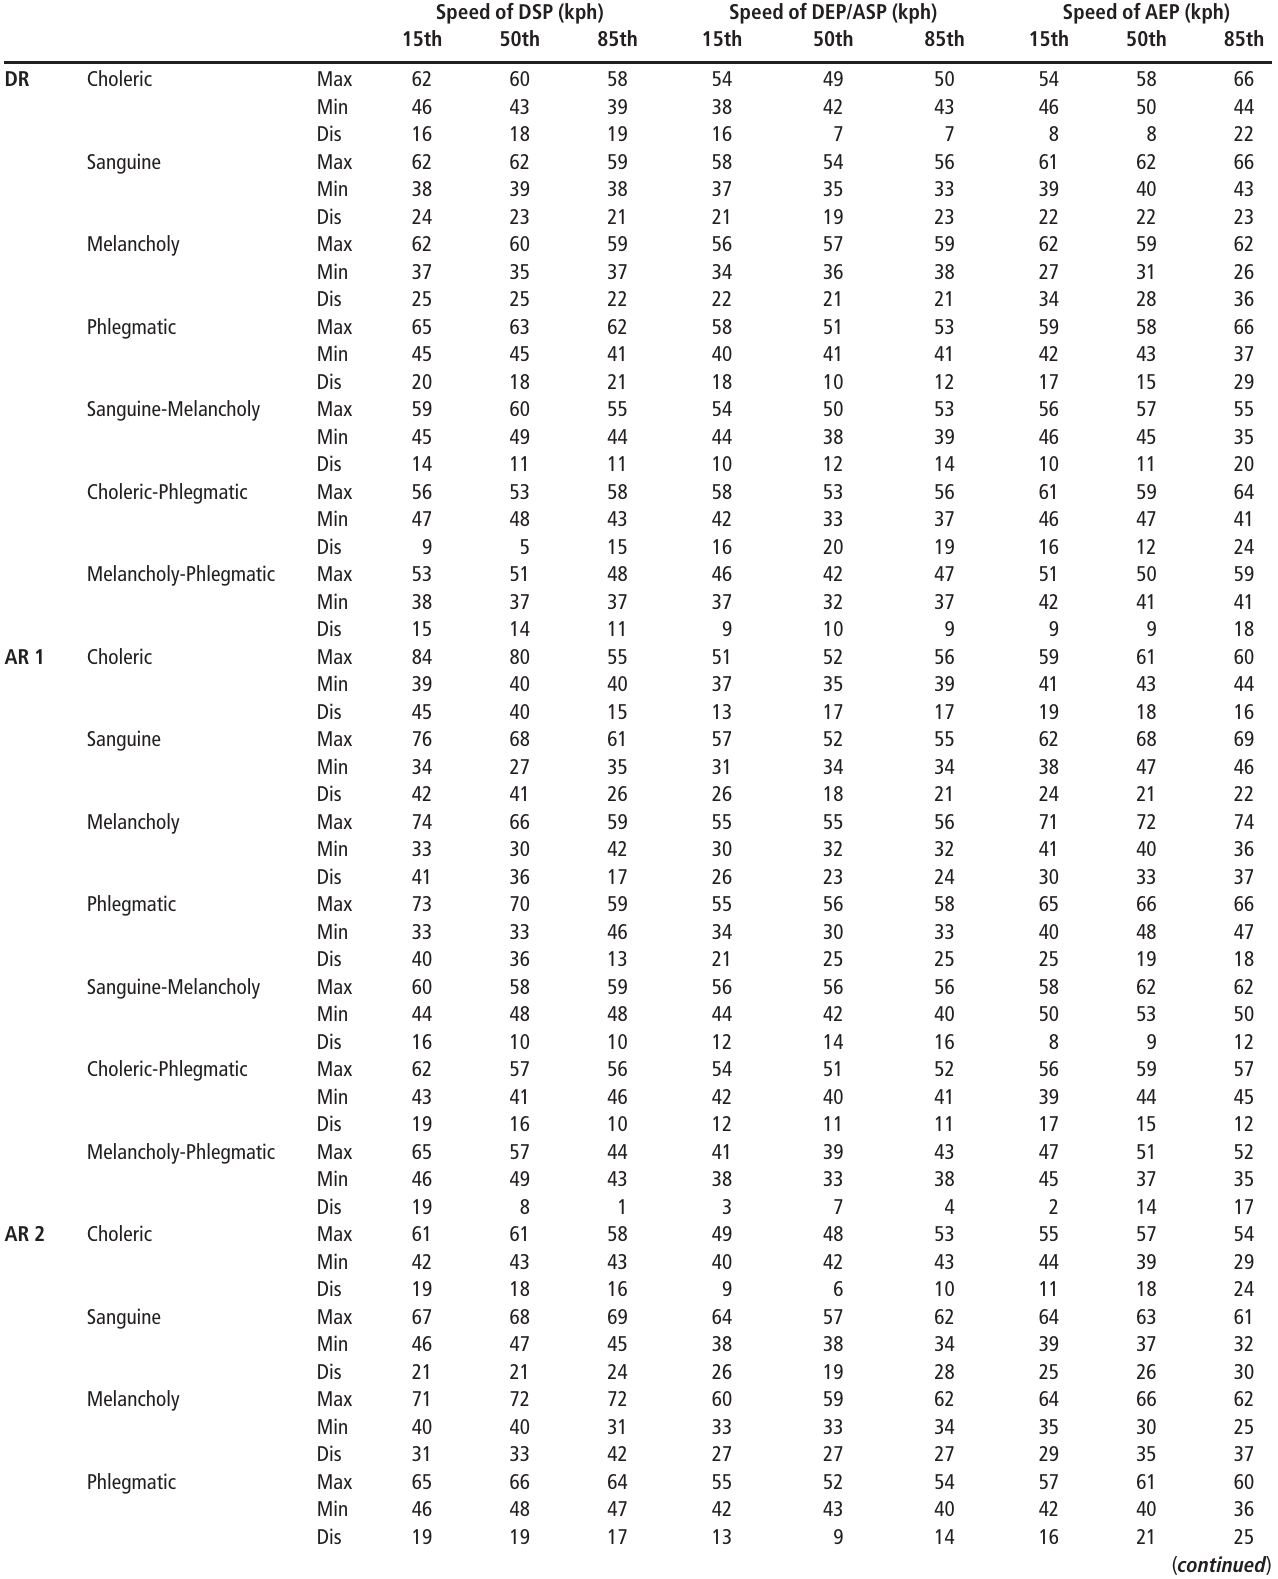
Table 6 Speed of feature points according to TTI